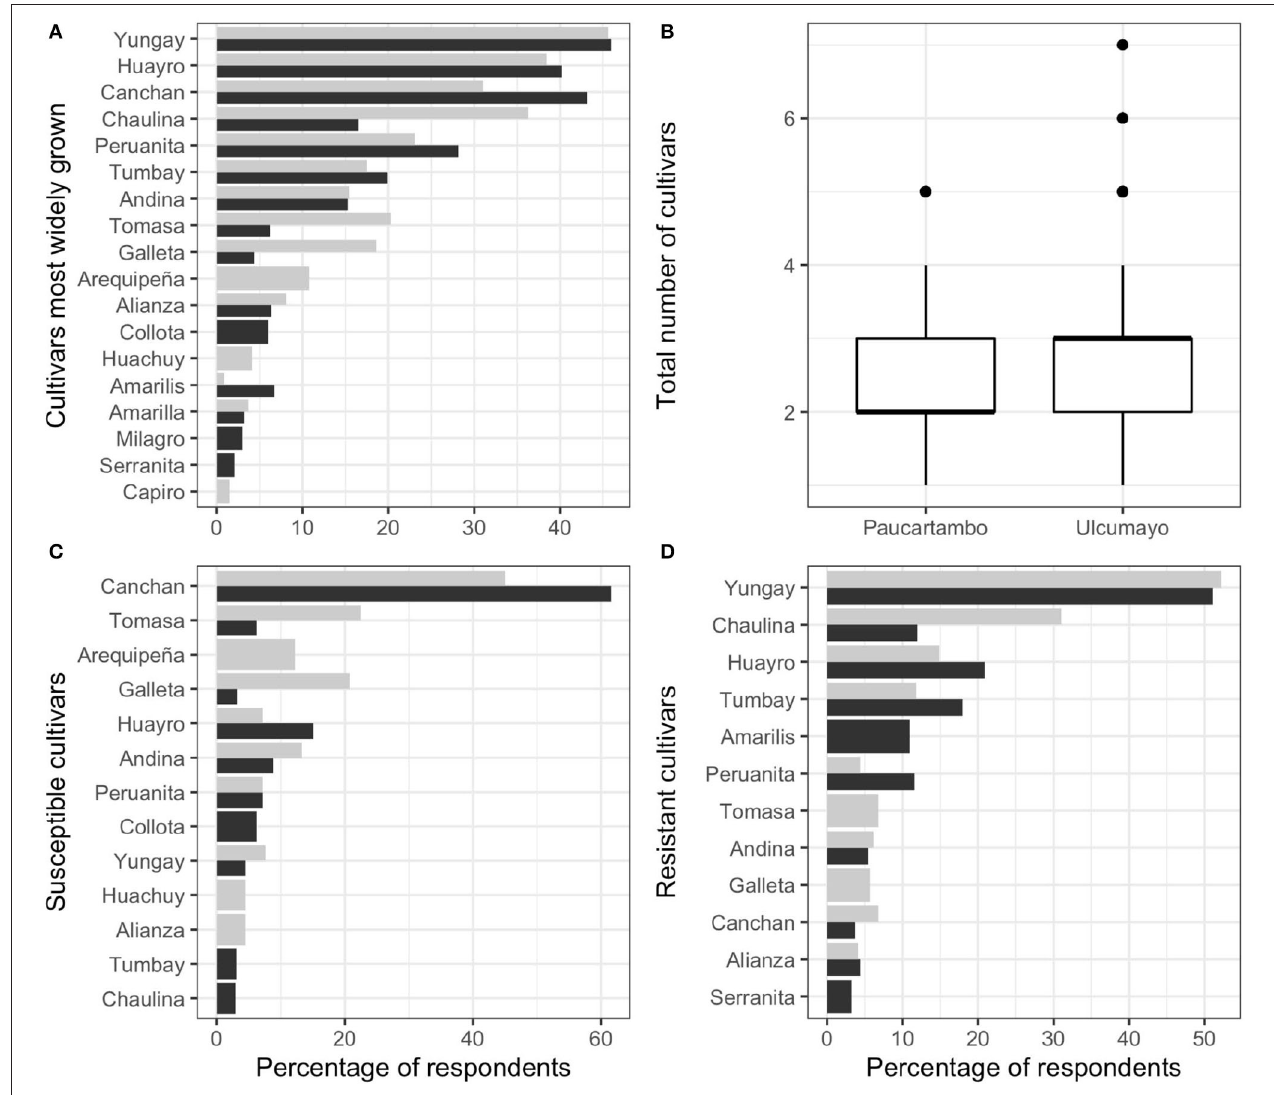
FIGURE 4 | Percentage of respondents choosing cultivars most widely grown (15 most important, A ), number of cultivars per farmer (B) , susceptible to late blight (C) , and resistant to late blight (D) in Paucartambo, black bars; Ulcumayo, gray bars. Fisher’s exact tests (A,C,D) for independence of factors were highly significant ( p < 0.0001), as was the Wilcoxon rank sum for differences in means ( B , p <